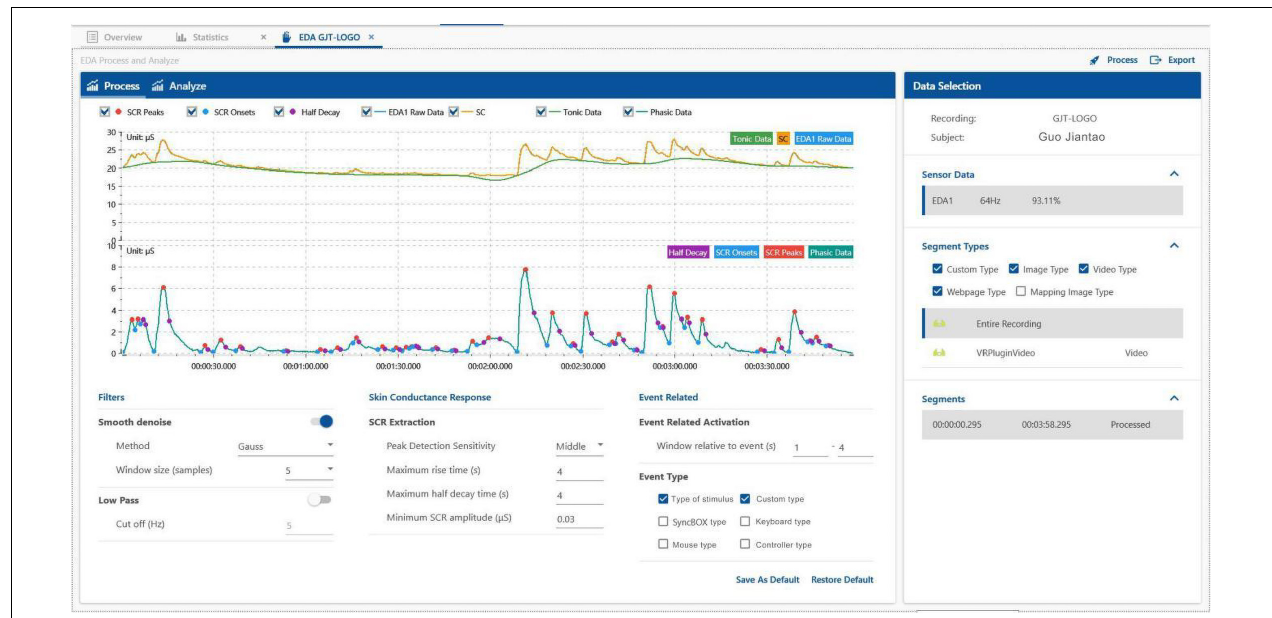
FIGURE 6 | EDA indicator records of individual samples displayed on the ErgoLAB platform during the experiment (Search and take screenshots from ErgoLAB by our research